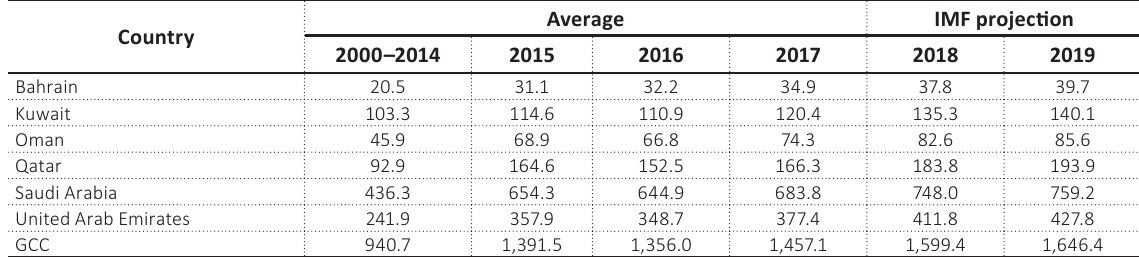
Source: International Monetary Fund dataset (average 2000–2014 to 2019).